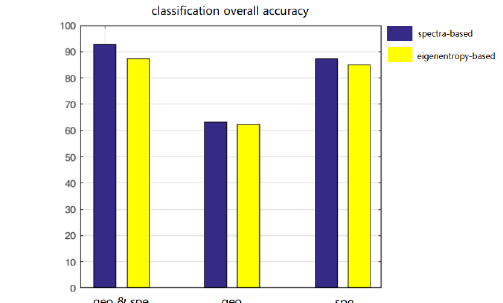
Figure 4. The comparative result of neighbour selection based on random forest classification. The left, medium and right bars indicate the result based on feature sets of the geometrical & spectral, only geometrical, and only spectral